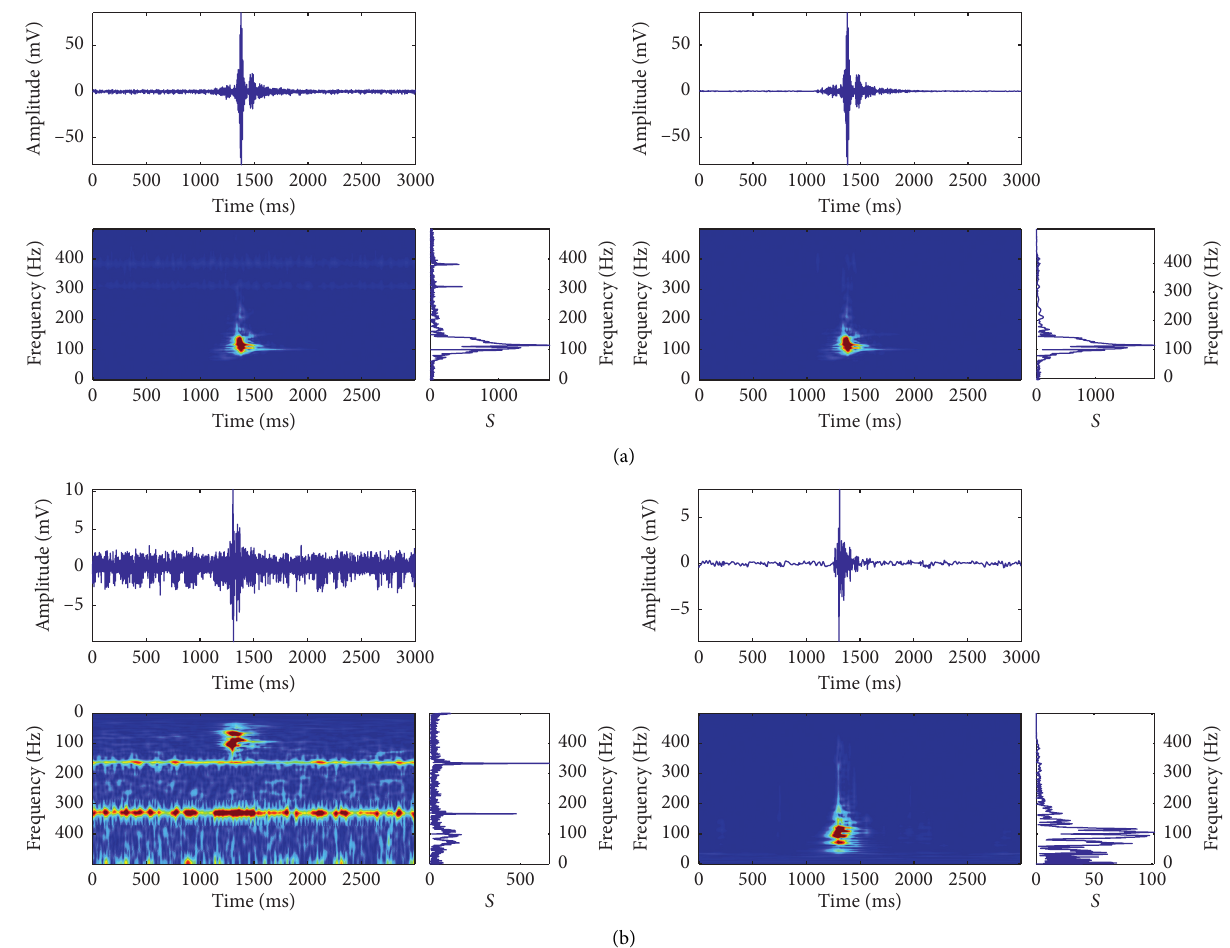
Figure 9: MWPT-IHHT method applied to real CSHF signals. (a) Signal #1 with high SNR . (b) Signal #2 with low